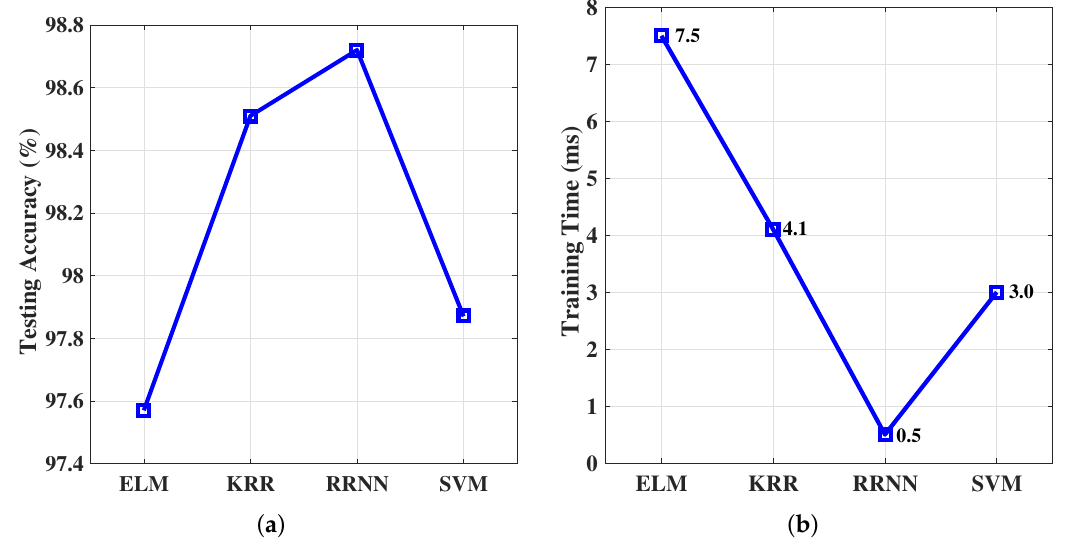
Figure 10. ( a ) Testing accuracy of ELM, KRR, and RRNN based on the ECAV feature set; ( b ) Training time for the ELM, KRR, and RRNN based on the ECAV feature